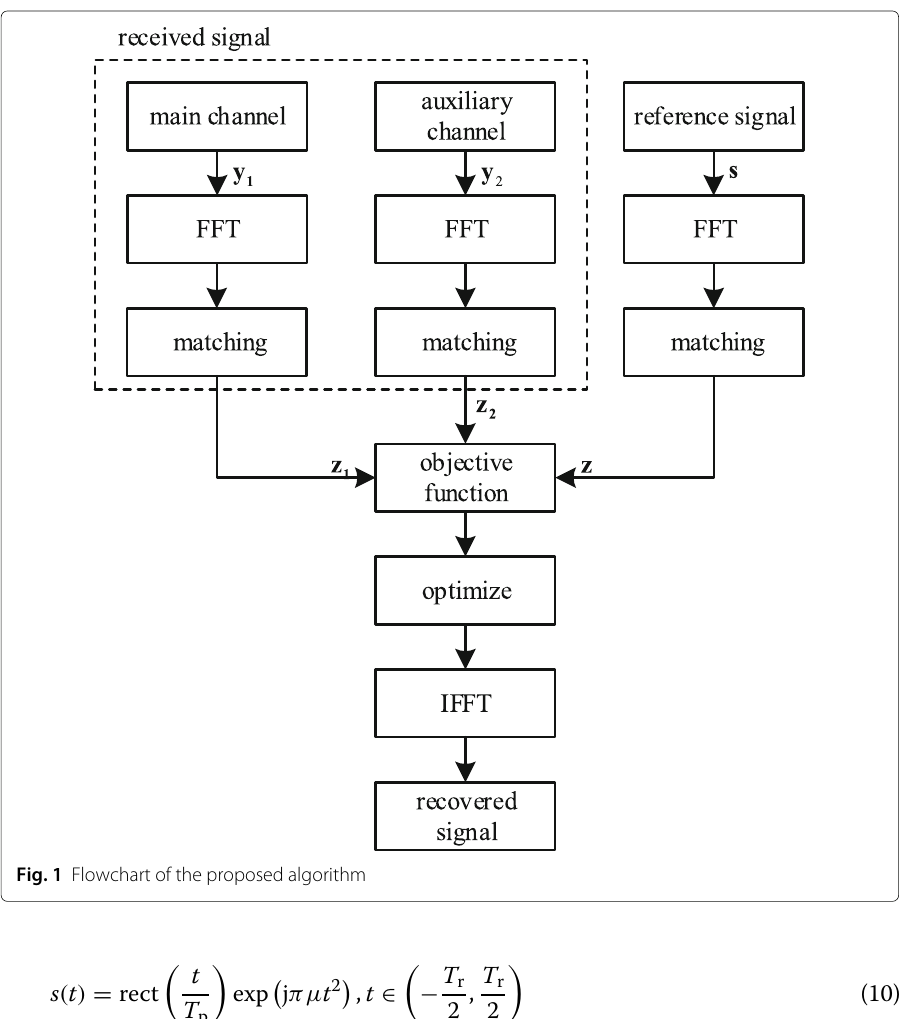
Fig. 1 Flowchart of the proposed